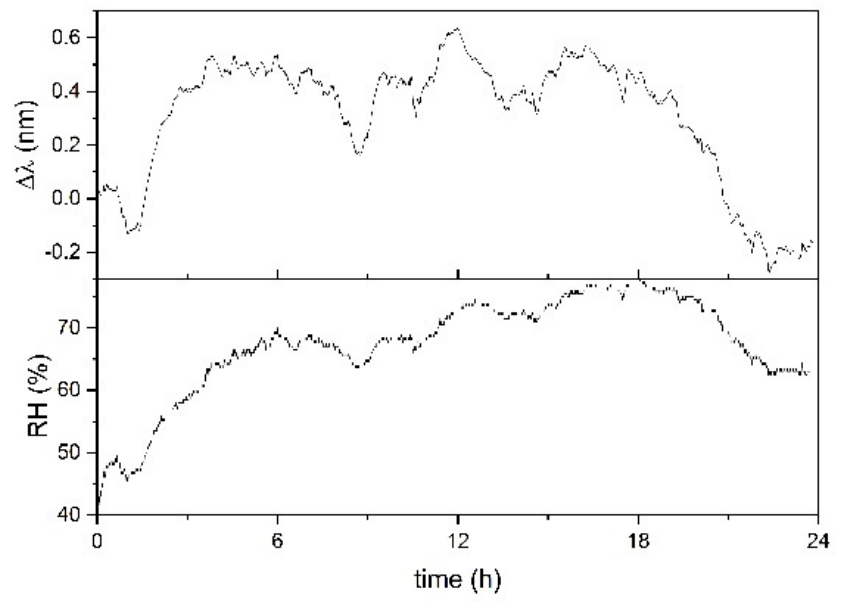
Figure 6. Response of sample FBG-PLA for 24 h in December. RH value was measured by the reference thermo-hygrometer.